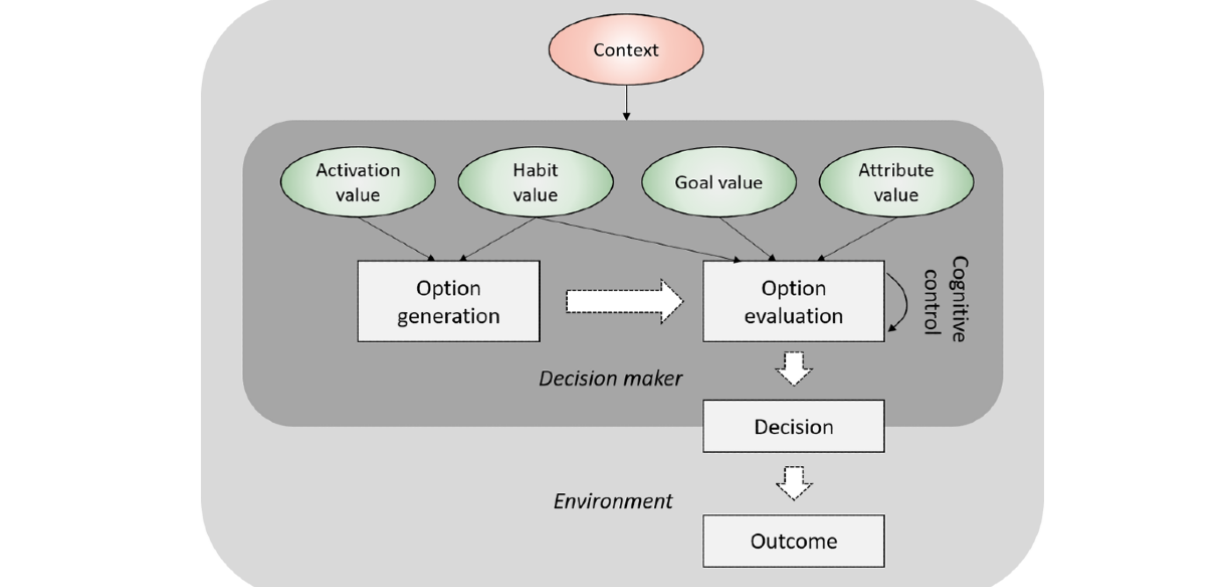
Figure 3. A two-step model of daily lifestyle decision